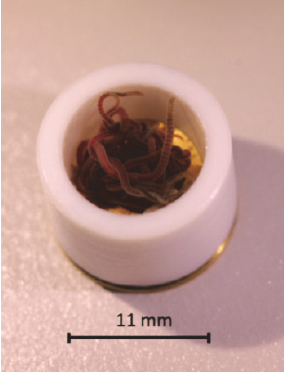
Fig. 2: Lumbriculus variegatus in the open measuring cell The worms which we used for our experiments were cultured under the same experimental conditions but on different feeds, mainly TetraMin ® fish feed and secondary potato sludge. TetraMin ® is a commercial tropical fish feed which provides a complete diet for ornamental